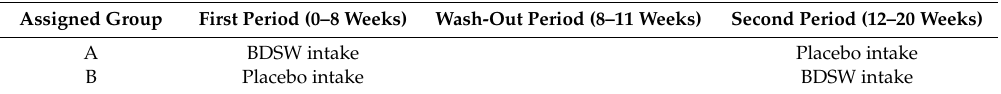
Table 2. Method of